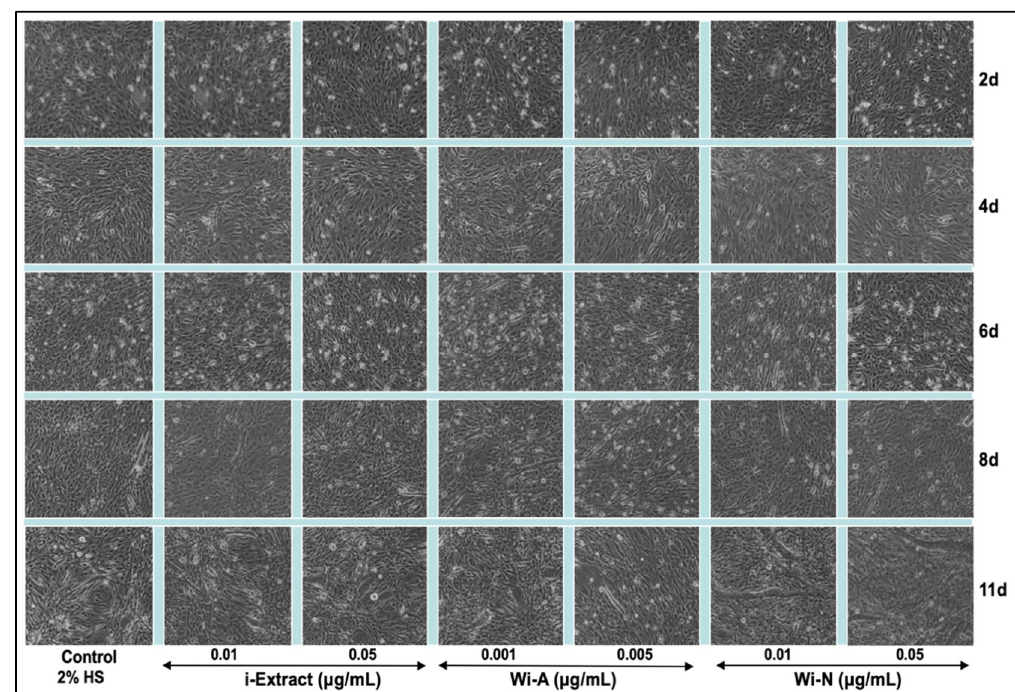
Figure 2. Time lapse observations on differentiation of C3 clone of C2C12 myoblasts treated with nontoxic doses of i-Extract, Wi-A, and Wi-N. i-Extract and Wi-A triggered some weak differentiation in C2C12 myoblasts; Wi-N-treated cells showed strong differentiation to myotubes.